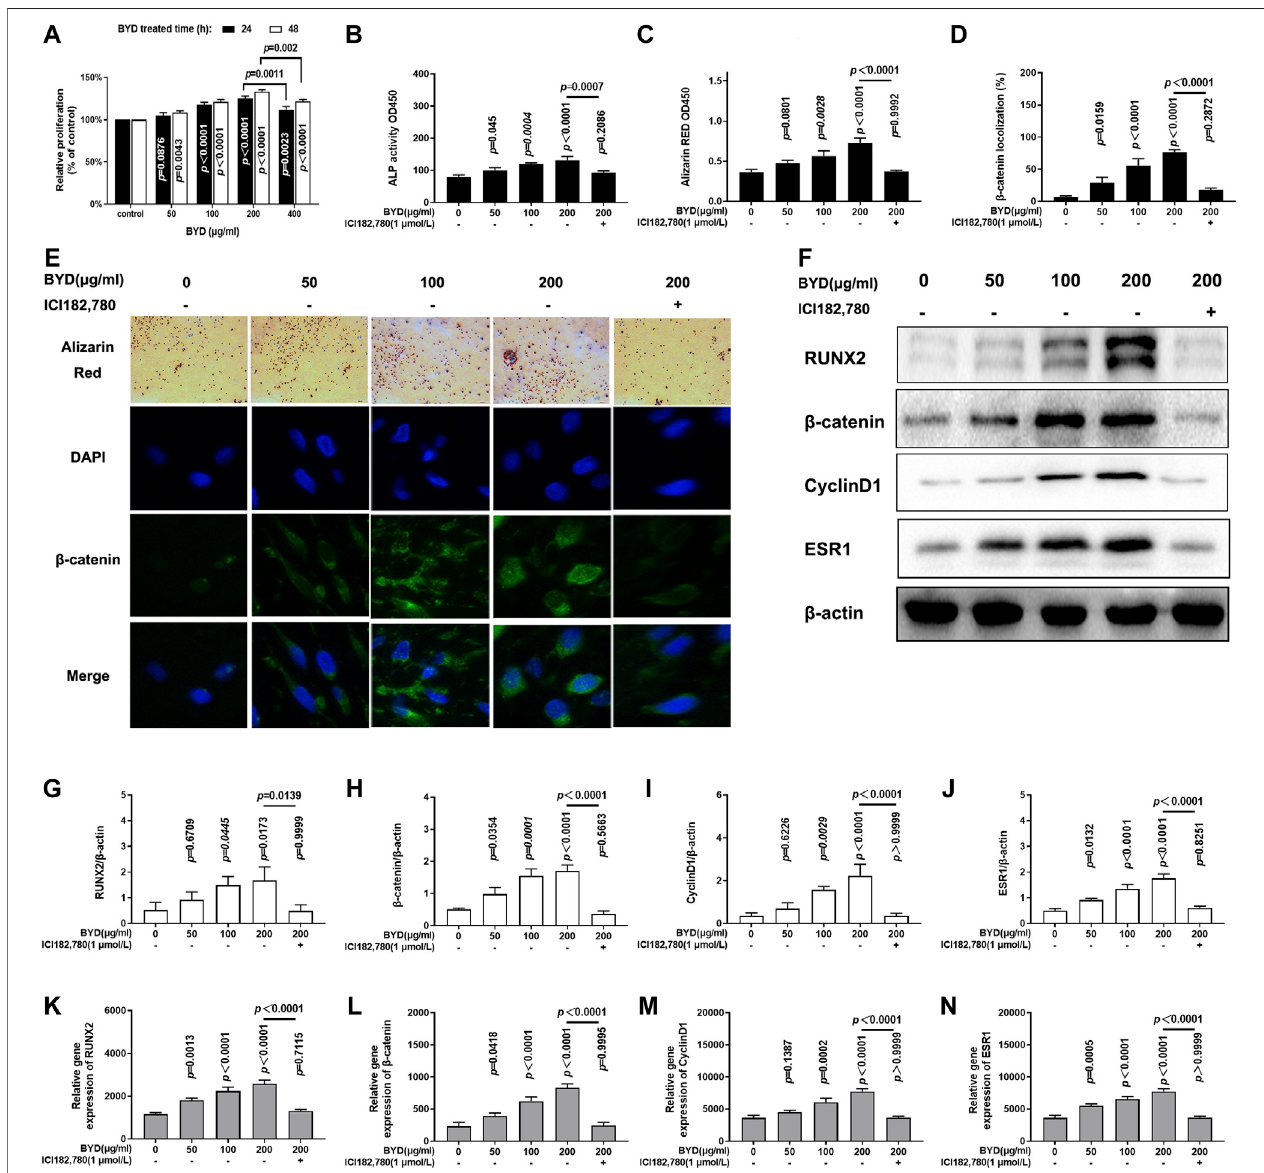
FIGURE 4 | BYD activated Wnt/ β -catenin signaling pathway to the promoted osteoblastic formation in vitro via ESR1. (A) Relative proliferation of various concentration of BYD (50, 100, 200, 400 μ g/ml). (B) Alkaline phosphatase (ALP) activity. (C) Result of Alizarin Red staining. (D) β -catenin localization analysis result. (E) Representativeimages ofalizarinredstainingandimmuno fl uorescencestainingof β -catenin. (F) Representative images ofwesternblotsofRUNX2, β -catenin,cylindD1, and ESR1. Quantitative analysis results of protein expressions analysis of (G) RUNX2, (H) β -catenin, (I) CyclinD1, and (J) ESR1. Quantitative analysis results of mRNA expression analysis of (K) RUNX2, (L) β -catenin, (M) CyclinD1, and (N) ESR1. THE exact p -value can be found in the corresponding